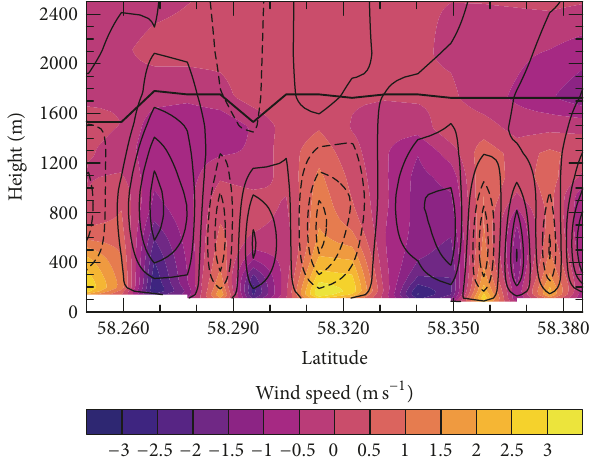
Figure 7: Vertical south-north cross-section from model simula- tions at 1400 UTC of horizontal wind speed (colour fill) and vertical wind speed (black contours) at longitude 15.9. The black contours are from − 0.9 to 0.9 by 0.3, where filled lines are positive values and dashed lines are negative. The thick black line shows the height of the